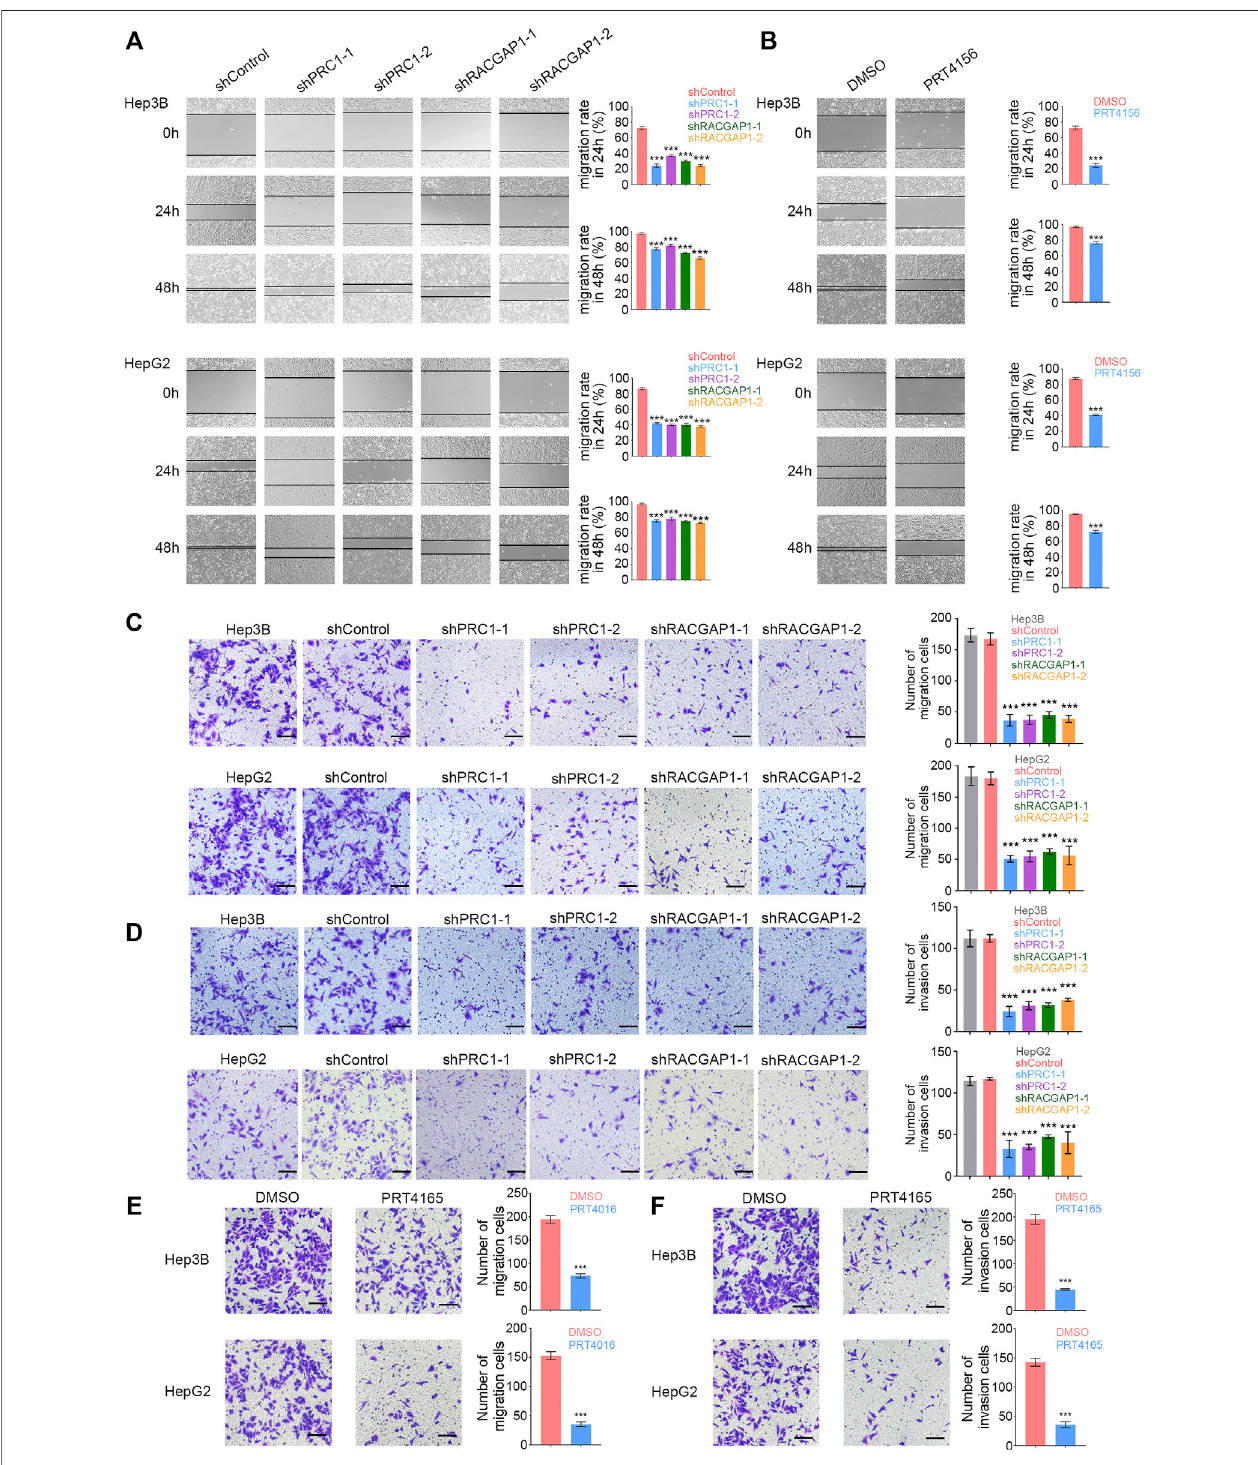
FIGURE 4 | PRC1 and RACGAP1 increase the metastasis of liver cancer. (A,B) (A) 1 × 10 5 PRC1 or RAPGAP1 knockdown Hep3B (upper panels) and HepG2 (lower panels) cells; (B) 1× 10 5 Hep3B (upper panels) and HepG2 (lower panels) cellstreated with 10 μ M PRT4165 or DMSO wereseeded in 24-well plates. The cells werescratched with10 μ Ltipsandphotographedat0and24 h.Themigrationratewasobtainedbytheformula:(Width0h − Width24h)/Width0h. (C,E) (C)2×10 4 PRC1orRAPGAP1knockdown Hep3B (upper panels) and HepG2 (lower panels) cells; (E) 2 × 10 4 Hep3B (upper panels) and HepG2 (lower panels) cells treated with 10 μ M PRT4165 or DMSO were seededtotheupperchamberandstainedwithcrystalvioletafter24 h. (D,F) (D)2×10 4 PRC1orRAPGAP1knockdownHep3B(upperpanels)andHepG2(lowerpanels)cells; (F) 2×10 4 Hep3B(upperpanels)andHepG2(lowerpanels)cellstreatedwith10 μ MPRT4165orDMSOwereseededtotheupperchambertreatedwithMatrigelandstainedwith crystal violet after 24 h. Scale bars, 100 μ m. *** p < 0.001, data are shown as mean ± s.d. Data are representative of at least three independent experiments.